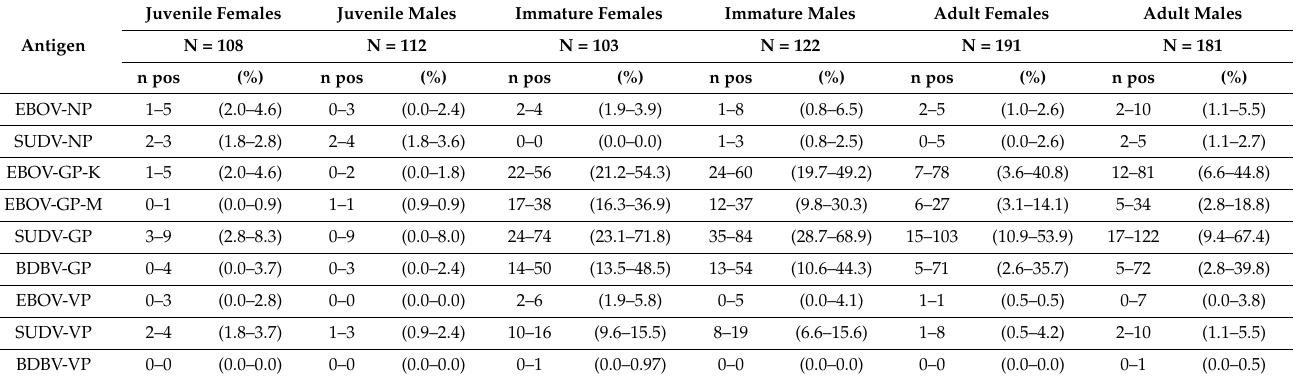
Figure 2. Percentage of bats per age category with antibodies to the different Ebolavirus antigens with less stringent cut-off (4 × standard deviation) ( a ); and stringent cut-off (statistical methods described in methods) ( b ) calculations. Bars correspond to the 95% confidence limits, corresponding p values comparing the antibody reactivities for each antigen among the different age categories are shown in Table 3. Table 2. Proportion of samples reactive with the different Ebolavirus antigens according to sex and age of the Eidolon helvum bats with stringent (statistical methods, see methods) and less- stringent (4 × SD of negative samples) cut-off values. The assay used recombinant proteins of Nucleoprotein (NP), Viral Protein-40 (VP40) or Glycoprotein (GP) for different Ebolavirus lineages: Zaire (EBOV), Sudan (SUDV), Bundibugyo (BDBV) and Reston (RESTV). GP proteins from the Mayinga (GP-M) and the Kissidougou (GP-K) strain were used for